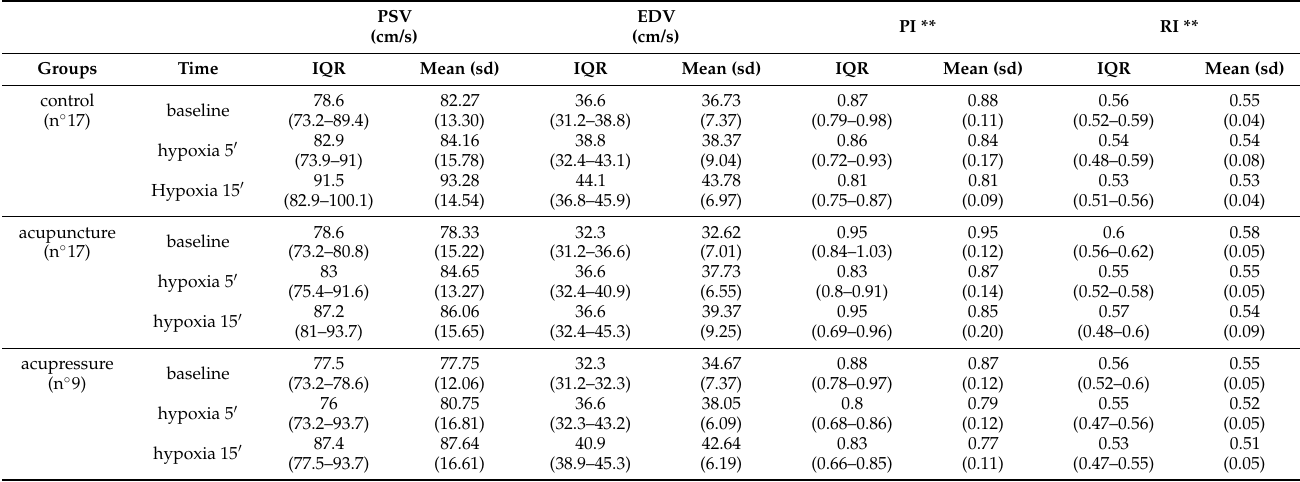
Table 2. CBF parameters (PSV, EDV, PI, RI) in control, acupuncture and band (acupressure) groups at baseline, after 5 and 15 min of hypoxia.